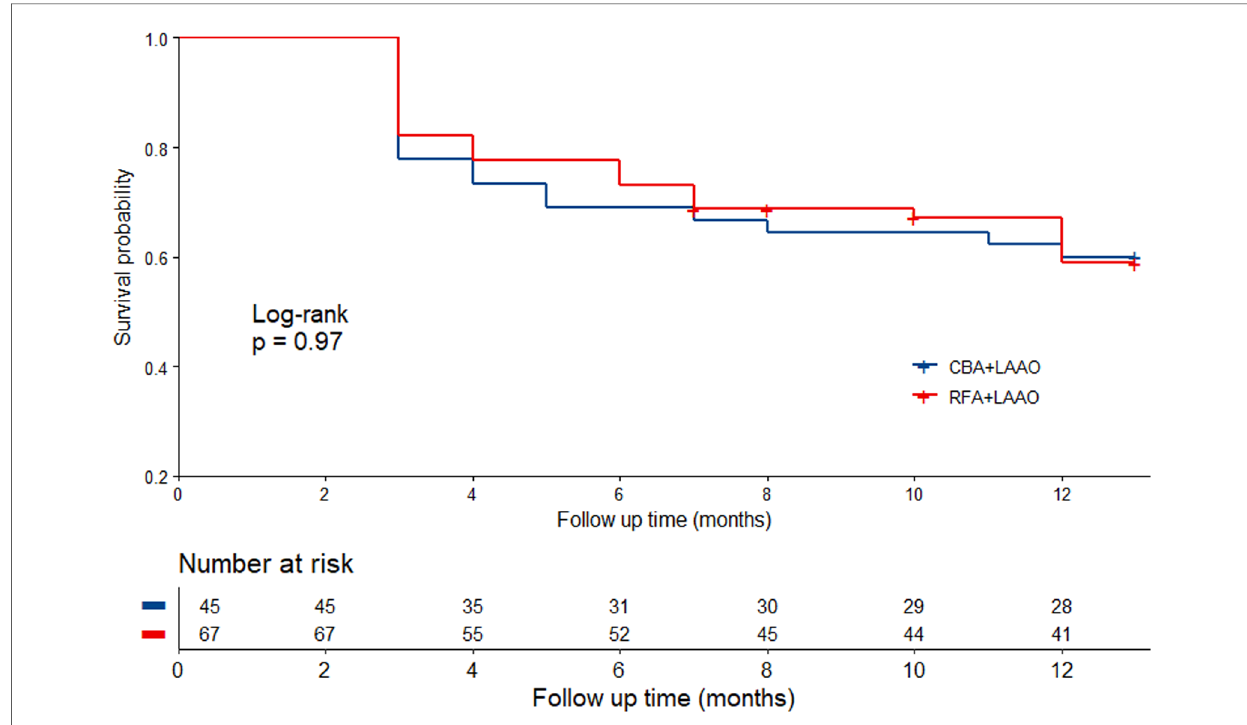
FIGURE 2 Time to arrhythmia recurrence in different groups. CBA, cryoballoon ablation; LAAO, left atrial appendage occlusion; RFA, radiofrequency ablation.